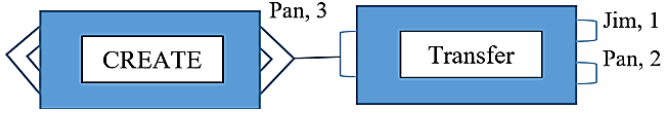
Figure 12. BigchainDB Transfer Transaction.